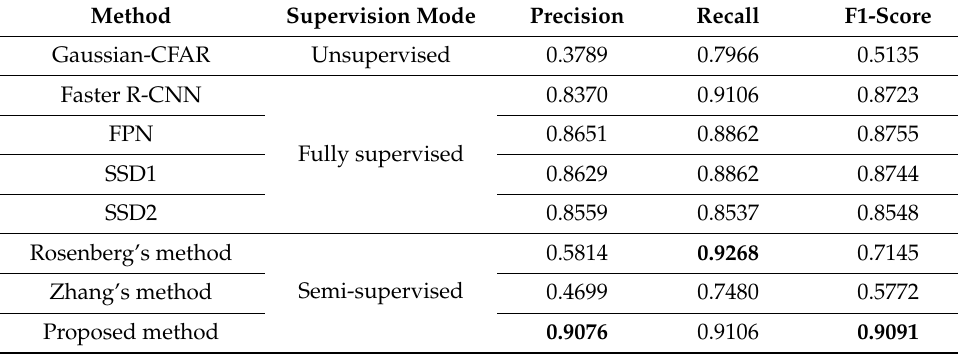
Figure 6. The target detection results compared with other methods for two test SAR images, where green rectangles represent the correctly detected target chips, red rectangles represent false alarms, and blue rectangles represent the missing alarms. ( a ) and ( b ) Gaussian-CFAR. ( c ) and ( d ) Faster R-CNN. ( e ) and ( f ) FPN. ( g ) and ( h ) SSD1. ( i ) and ( j ) SSD2. ( k ) and ( l ) Rosenberg’s method. ( m ) and ( n ) Zhang’s method. ( o ) and ( p ) proposed method. Table 1. Overall evaluation of different target detection methods.